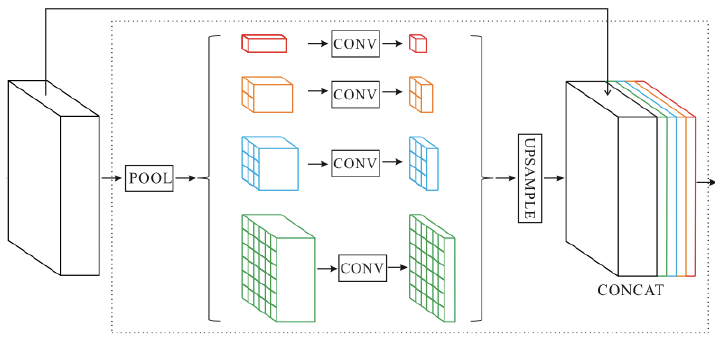
Figure 4. The architecture of the Pyramid Pooling Module